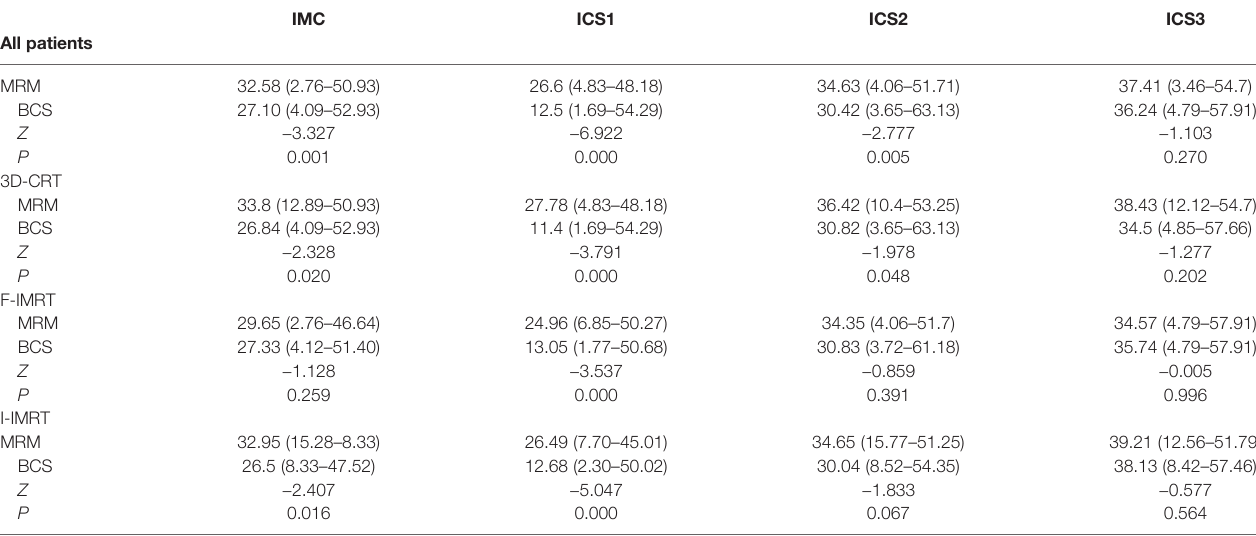
TABLE 2 | Comparison of the incidental IMC dose between the MRM and BCS